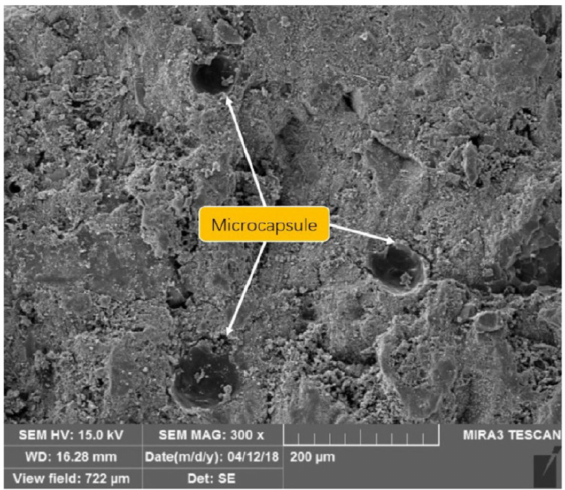
Figure 9. The presence of large pores due to broken microcapsules in the cementitious matrix. Reproduced with permission from [51]. Copyright 2019,